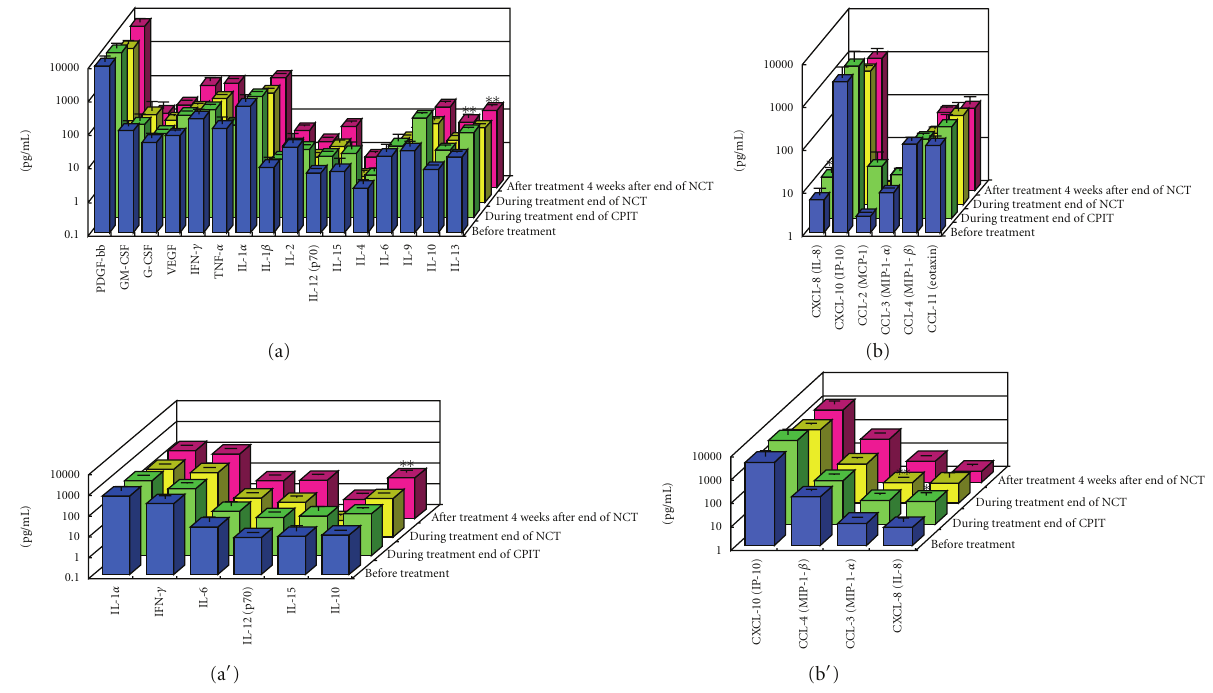
Figure 4: E ff ect of RBV plus PEG-IFN-alpha 2b using an “induction” approach with CPIT (NCT) on serum cytokines (a), (a (cid:3) ) and chemokines (b), (b (cid:3) ) in chronic hepatitis C patients with high viral load, genotype 1b (serotype I), and wild or intermediate types of ISDR (late virological responders). RBV: ribavirin, PEG-IFN: pegylated interferon, CPIT: cyclic and periodic interferon treatment, NCT: novel combination treatment. Significant di ff erence: ∗ P < 0 . 05, ∗∗ P < 0 .